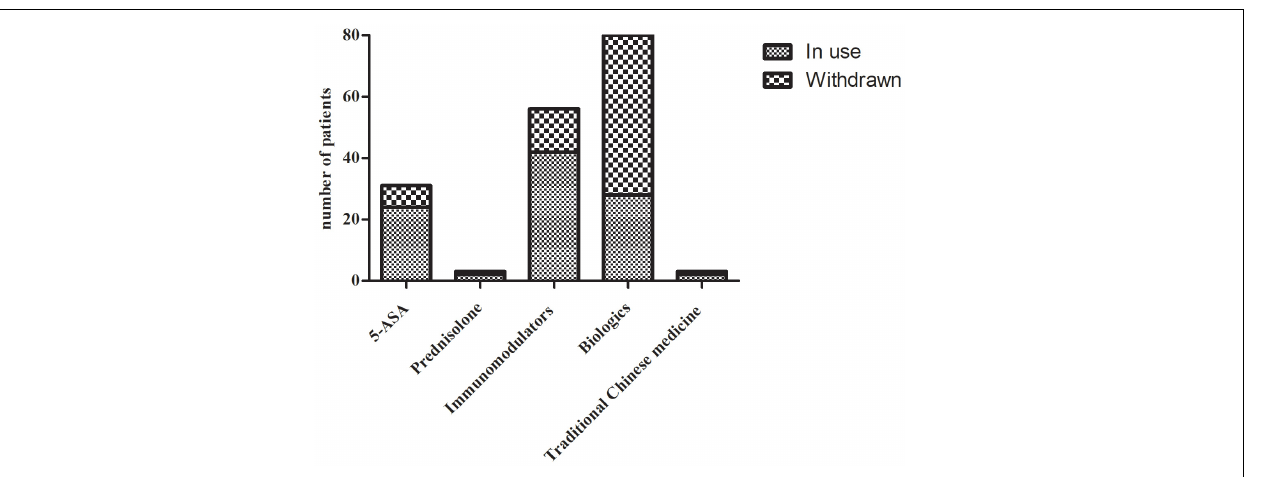
health authorities, 55 (35.95%) CD patients finished the COVID- 19 vaccination, and the SARS-CoV-2 Delta variant is well known to CD patients (7.46 ±